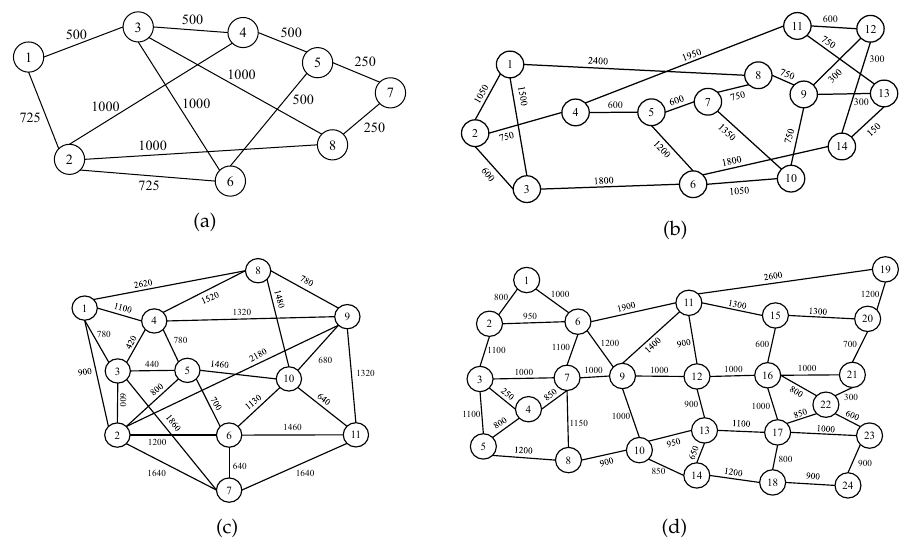
Figure 3. Optical network topologies: ( a ) 8-node, ( b ) 14-node NSFNET, ( c ) 11-node COST 239, and ( d ) 24-node US